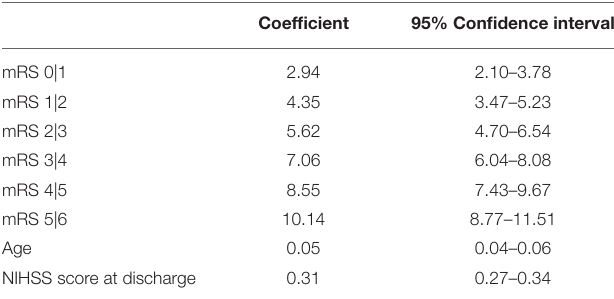
TABLE 2 | Ordinal logistic regression predicting 90-day mRS derived from the full derivation set ( n =